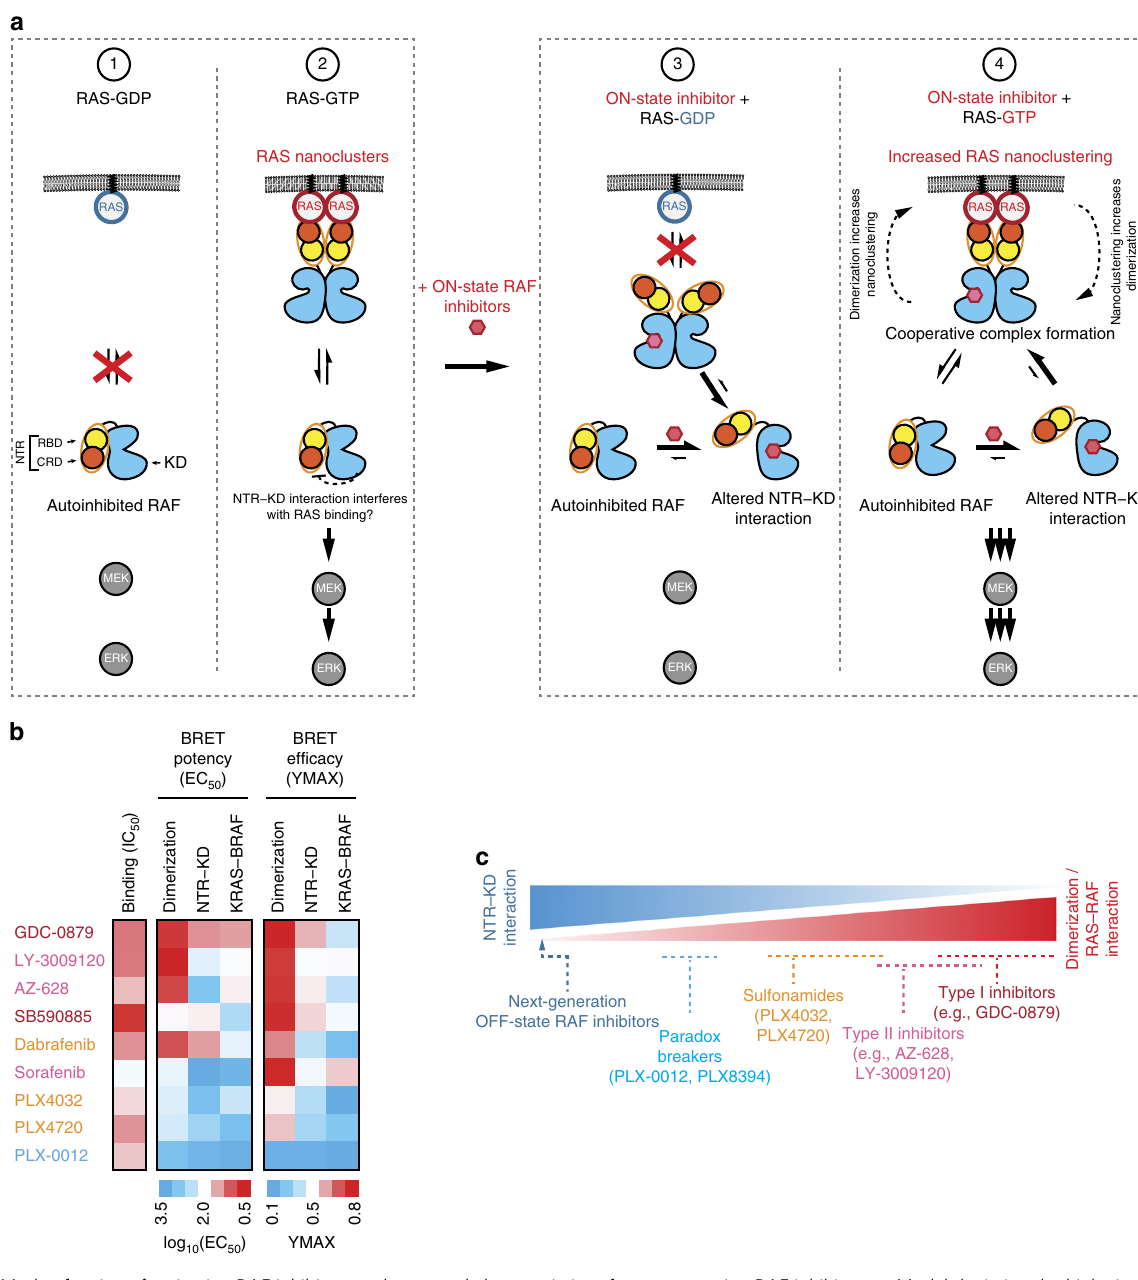
Fig. 6 Mode of action of activating RAF inhibitors and proposed characteristics of next-generation RAF inhibitors. a Model depicting the biological mode of action of RAF inhibitors in untreated (1 and 2; left) or inhibitor-treated cells (3 and 4; right). (1) In quiescent cells where RAS activity is low, RAF proteins are autoinhibited through an interaction between their N-terminal regulatory region (NTR) and their kinase domain (KD). Upon physiological RAS activation or in RAS-activated cancer cells (2), RAF proteins shuttle between an autoinhibited monomeric state in the cytoplasm and an activated dimeric state bound to RAS − GTP at the plasma membrane. At steady-state, ERK signaling is moderated by this ON/OFF equilibrium. (3) ON-state RAF inhibitors disrupt the normal NTR − KD interaction. In cells with low-RAS activity, derepressed RAF can dimerize but this process is not stabilized by active RAS and therefore does not lead to paradoxical pathway activation. (4) RAS activity and RAF inhibitors co-operatively promote RAS − RAF complex formation and RAF dimerization. On the one hand, NTR − KD disruption is triggered by two separate means (RAS-binding to the RBD and compound binding to the catalytic cleft) resulting in dissociation. On the other hand, the increase in RAF effective concentration when bound to RAS nanoclusters coupled with the closed/active-like kinase domain conformation stabilized by the inhibitors leads to increased side-to-side RAF dimerization. In turn, RAF dimerization further augments the population of RAS nanoclusters. Together, these events co-operatively drive RAS − RAF complex formation and RAF dimerization. At sub-saturating compound concentrations, this phenomenon leads to catalytic transactivation of the compound-free protomer. b Unbiased clustering of RAF inhibitors based on their effects on dimerization, NTR − KD interaction and RAS − RAF association (BRET EC 50 s and YMAXs values served as clustering parameters). The EC 50 s and YMAXs used for clustering were the average of three independent repeats (Supplementary Data 1). c Each class of RAF inhibitors is positioned along an axis from ON-state (red) to OFF-state compounds (blue). Ideal (OFF-state) RAF inhibitors would not allow kinase domain dimerization, but would stabilize the NTR − KD interaction, thereby maintaining RAF proteins in an autoinhibited state irrespective of the status of RAS